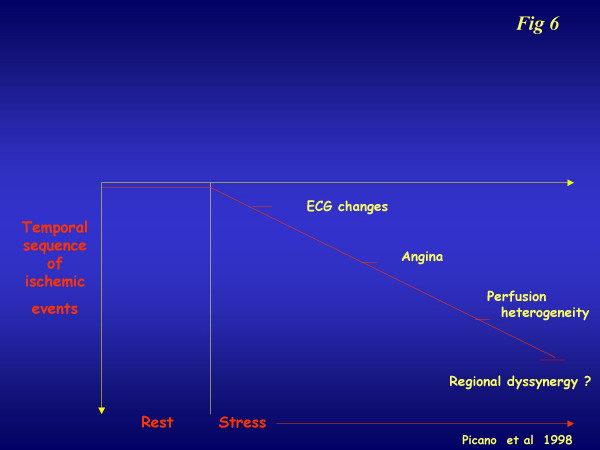
The alternative ischemic cascade, triggered by microvasculature dysfunction. The various markers are a different time sequence in comparison with the classical ischemic cascade.